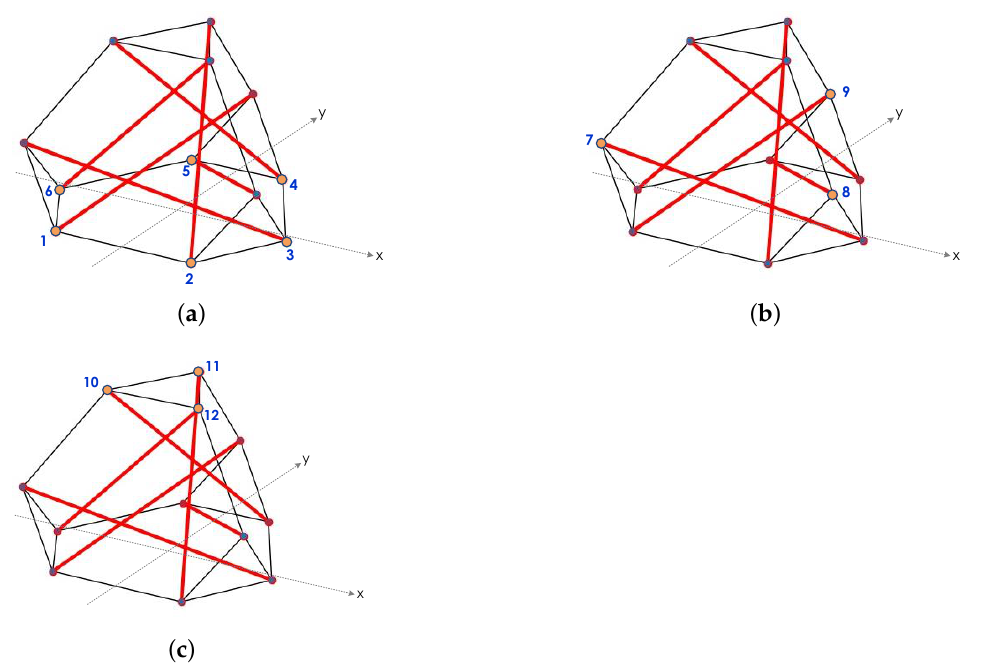
Figure 14. Three steps of the coordinate designation for the 3D-truncated tetrahedron tensegrity. ( a ) Step 1: Nodes 1 to 6. ( b ) Step 2: Nodes 7 to 9. ( c ) Step 3: Nodes 10 to 12.